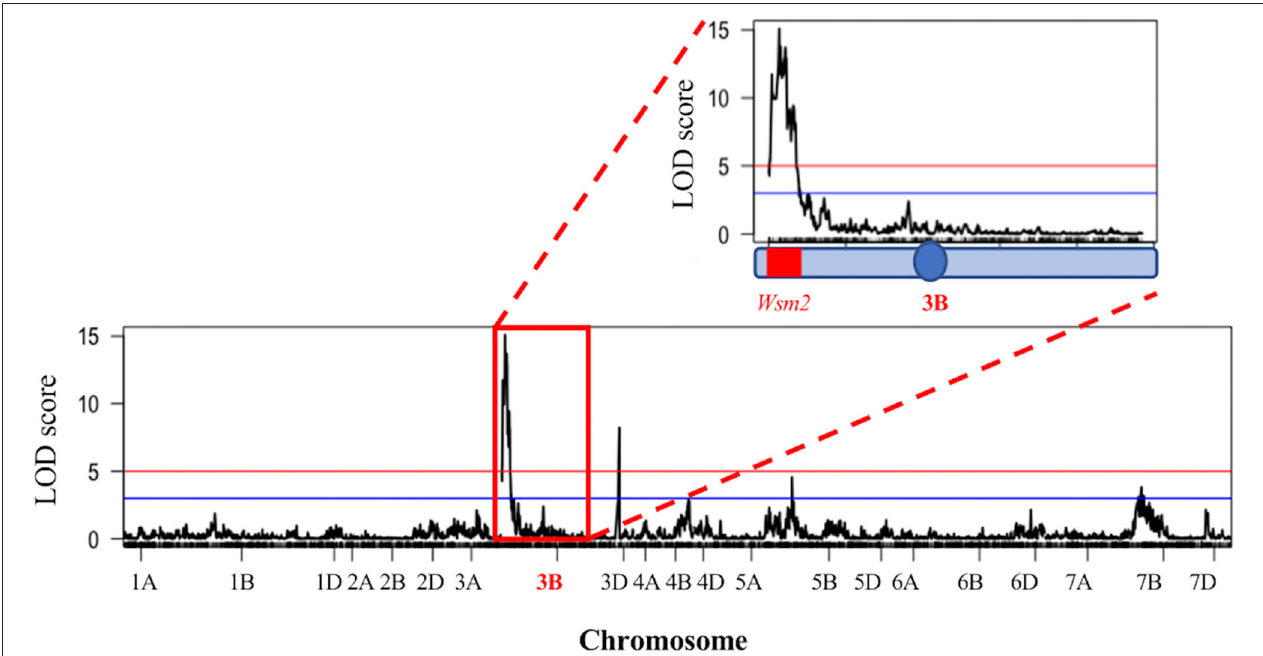
FIGURE 2 | Quantitative trait loci (QTL) mapping for WSMV resistance in a “Snowmass” × “Antero” doubled haploid (DH) population ( n = 116). Horizontal blue line indicates LOD = 3 ( P < 1e-3) and horizontal red line indicates logarithm of odds (LOD) = 5 ( P < 1e-5). Red box indicates chromosome 3B. The blue circle indicates the position of chromosome 3B centromere, and the Wsm2 region is highlighted in